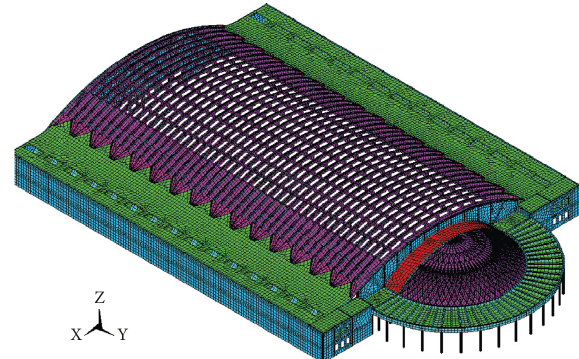
Figure 5: A 3D view of the global finite element model of the hall showing its mesh and different materials (classified by colours).